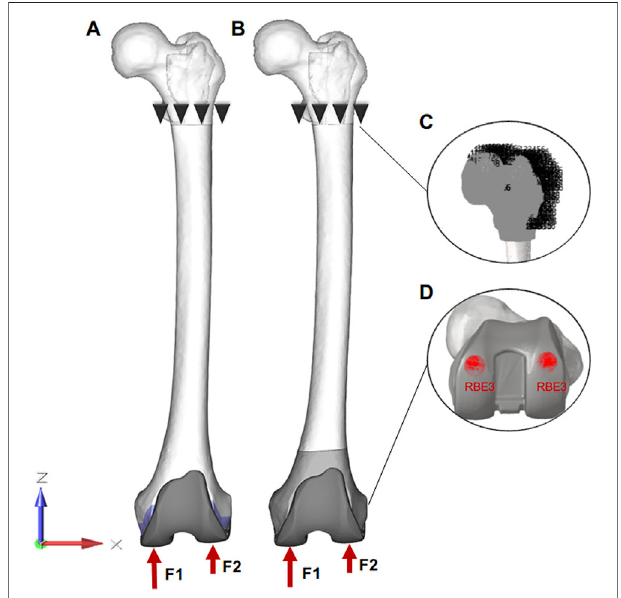
FIGURE 3 | The fi nal fi nite element model of surgical procedures. (A, B) : Loads and constraint conditions on the femur. F1 and F2 represent the force on the medial and lateral femur, respectively. (C) all points of the proximal femurare limited to 0 in six degrees offreedom. (D) forces are applied to the “ Rigid body element three ” area in Hypermesh, which can make the force more uniform.